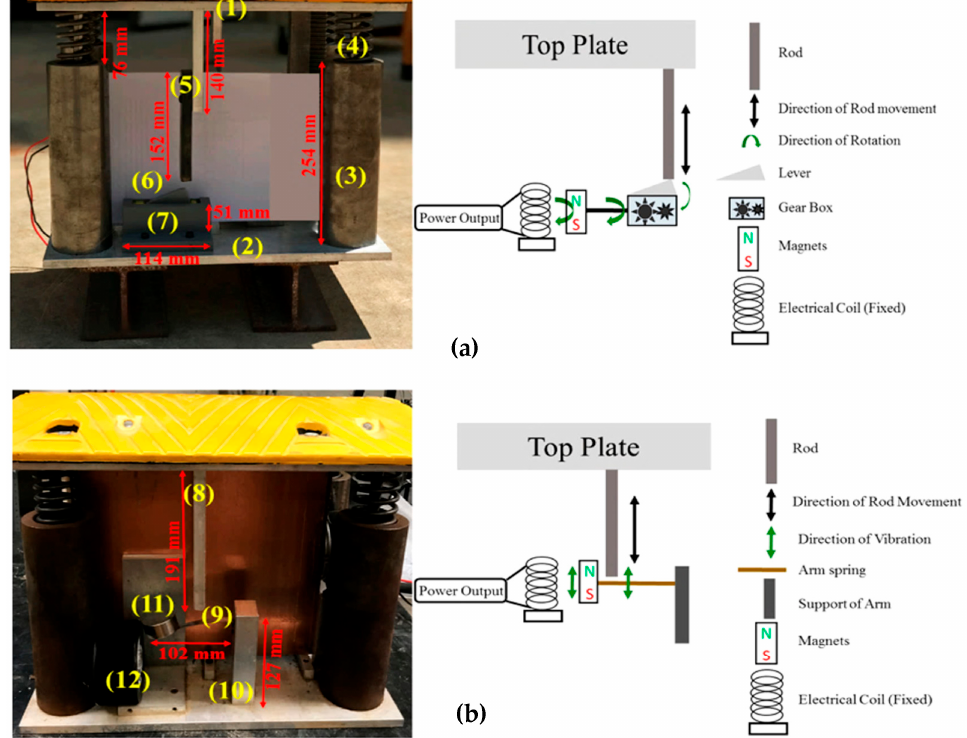
Figure 14. Prototypes of electromagnetic energy harvesting prototypes with rotational or cantilever mechanisms proposed by Gholikhani et al. in 2019: ( a ) Rotational mechanism prototype: (1) top plate; (2) bottom plate; (3) cylindrical support; (4) compression springs; (5) two-part rod; (6) lever; (7) box with magnets, coils, gears, and torsional springs. ( b ) Cantilever-mechanism prototype: (8) rod, (9) spring arm, (10) arm support, (11) magnets, (12) electrical coil (Reprinted with permission from Ref. [116]. 2019, MDPI)